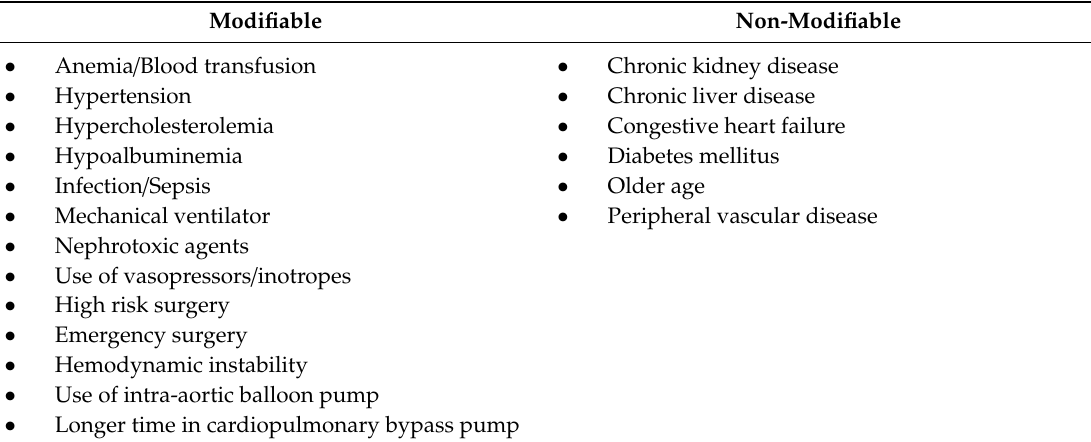
Table 5. Risk factors for AKI [129–132].